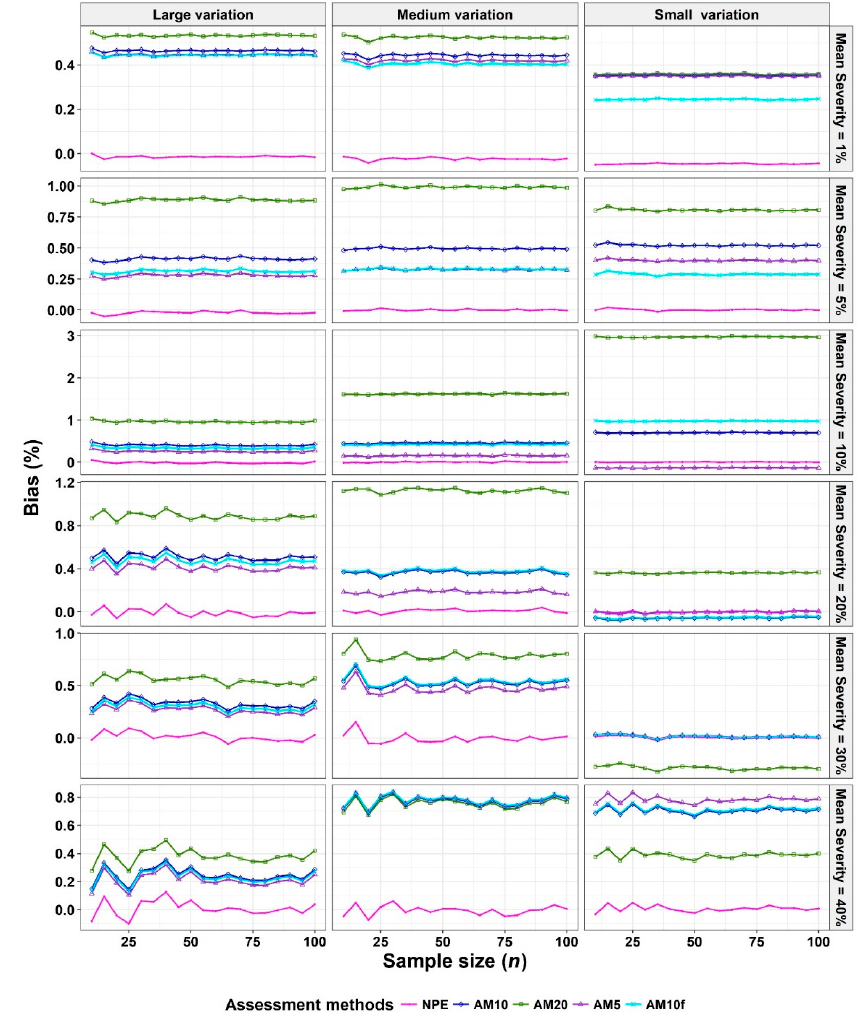
Figure 7. The relationships between the bias of mean disease severity estimates and sample size ( n ) (from n = 10 to 100 in n = 5 increments) for each of the different scales used, with conditioning on a range of “actual” mean disease severities (1%, 5%, 10%, 20%, 30%, and 40%) and variance (represented by large, medium, and small variation). The simulation process was repeated 10,000 times. Assessment methods were: (i) NPE (nearest percentage estimate); (ii) AM10 (10% linear scale emphasizing severities ≤ 50% disease, and with additional intervals at severities <10%); (iii) AM20: Similar to the structure of AM10 (both scales have the same structure at ≤ 10%), this scale has wider ordinal scale intervals for disease severities 10 through 50% based on a 20% linear scale; (iv) AM5: Similar to the structure of AM10 (both scales have the same structure at ≤ 10%), this scale has narrower ordinal scale intervals for disease severities 10 through 50% based on a 5% linear scale; (v) AM10f: Similar to the structure of AM10, this scale has 10% linear intervals at >10%, but has finer intervals at ≤ 10% disease.